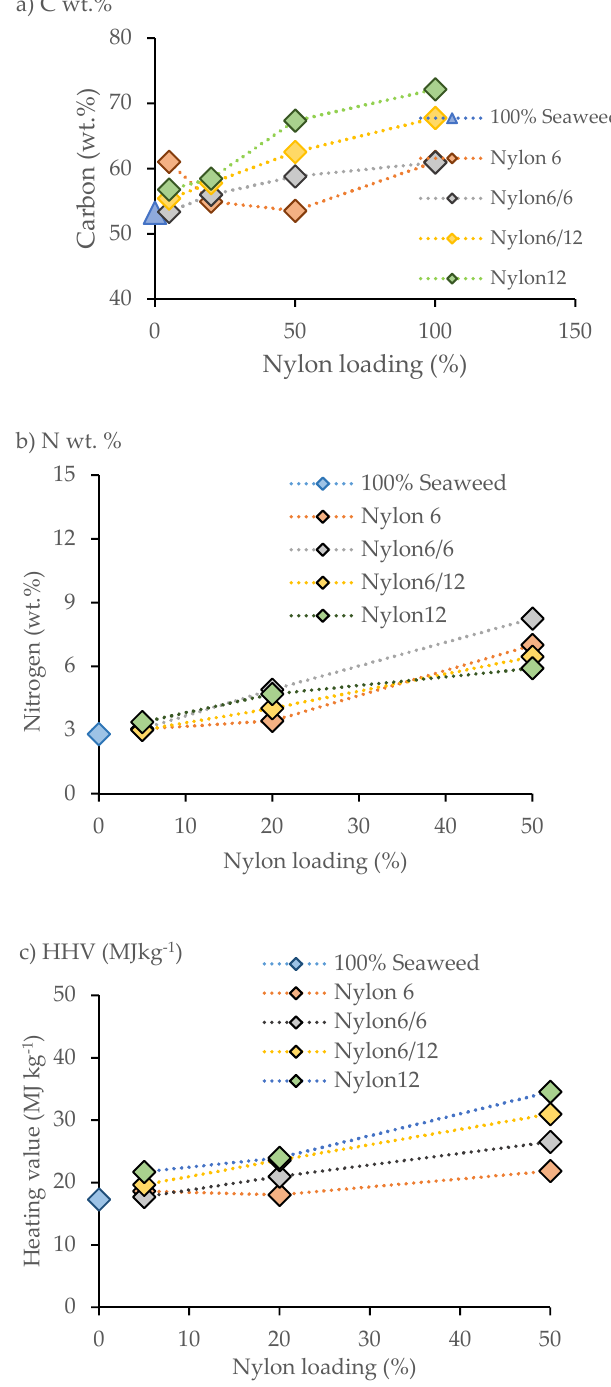
Figure 6. Elemental composition of the biochar of 5, 20 and 50 wt.% nylon contents of nylon 6, nylon 6/6, nylon 6/12, and nylon 12: ( a ) carbon wt.%, ( b ) nitrogen wt.%, ( c ) HHV of the biocrudes .